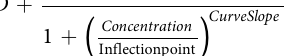
The data were fitted using a four-parametric logistic regression model 41 (1) in ImageJ (Curve Fitter > Rodbard). The assay system gives a sigmoidal curve and we used the 4 parametric logistic regression model because it pro- vided the best curve fit. The model takes into account the minimum and maximum values, the point of inflection, and the slope of the curve. Thereafter, the model was used to estimate the concentrations for the limits of detec- tion (LOD) and lower limits of quantification (LLOQ) by calculating the concentrations corresponding to the fitted curves at OD values corresponding to average background + 3 standard deviations for LOD; and at average background + 10 standard deviations for